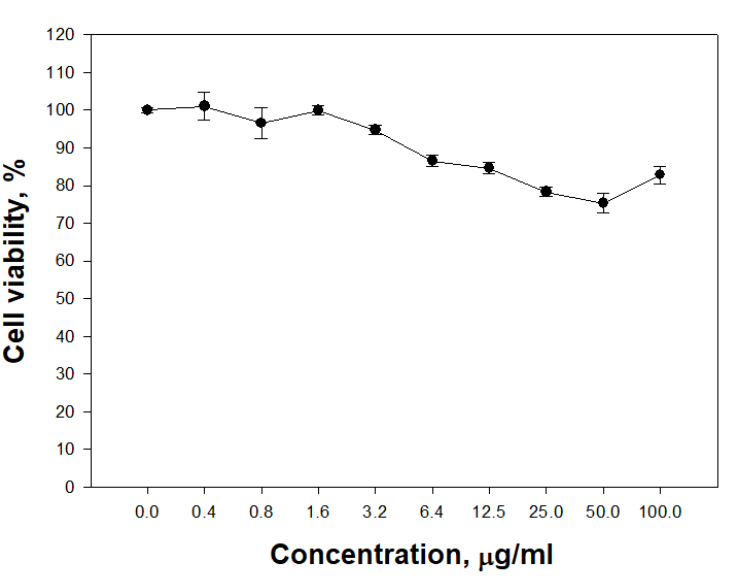
Figure 10. Cytotoxic activity of PldA-GFP IBs on mouse neuroblastoma Neuro-2a cells. The data are presented as the mean ± SEM values ( n = 3).